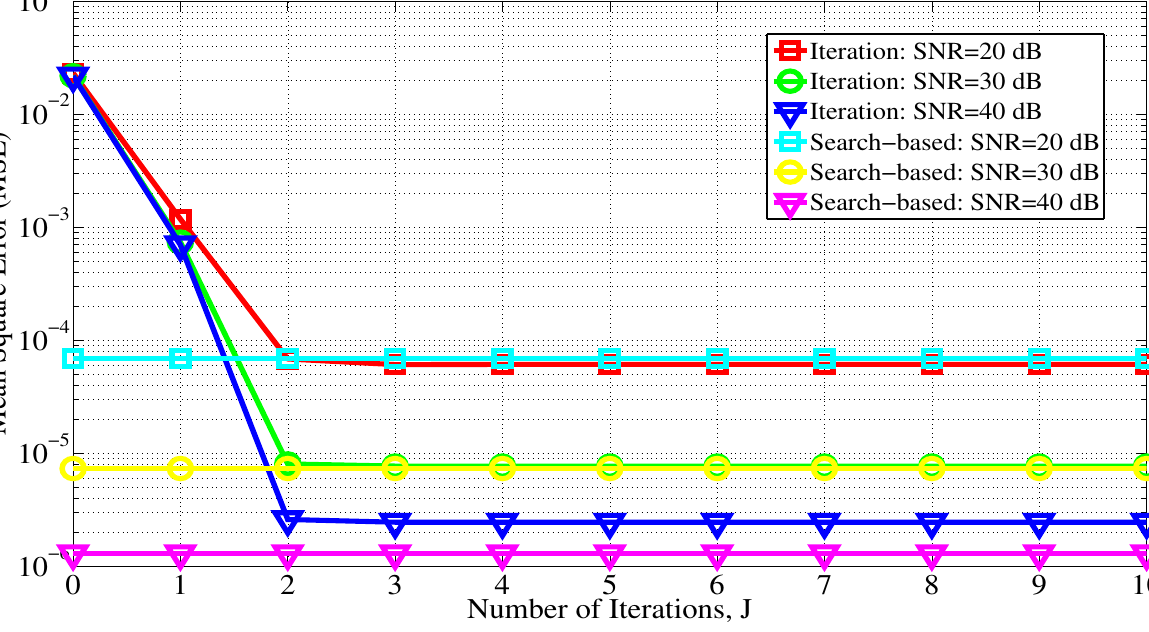
Figure 1. Convergence behavior of the proposed iterative CFO estimation for different SNRs. N = 256, K = 64, (cid:15) = 0.3 and τ = 4. d